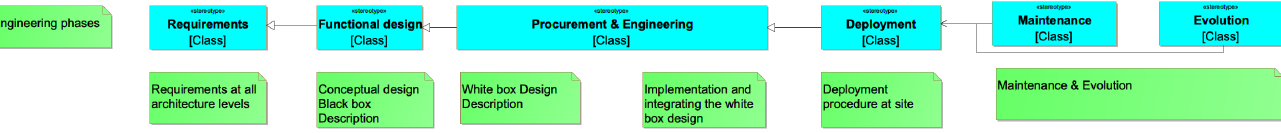
Figure 1. The engineering process applied in this paper is based on ISO 81346 as extended and refined by Urgese et al.